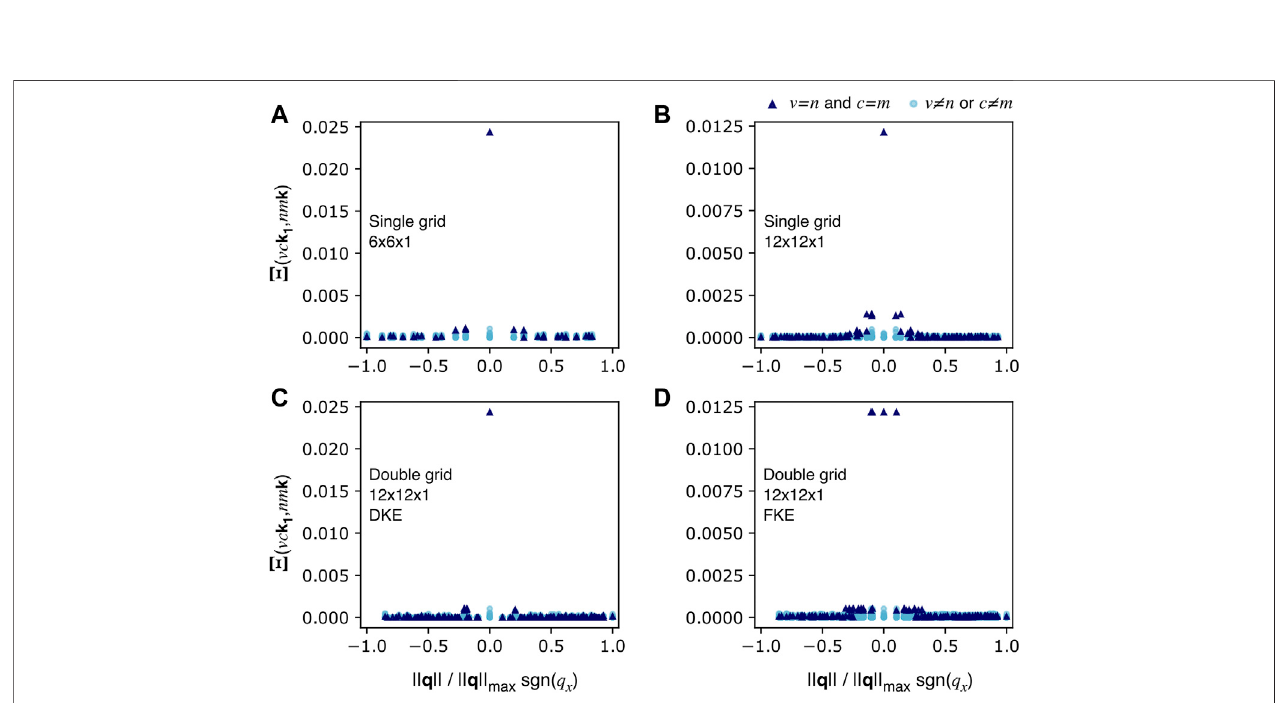
FIGURE 6 | Module of the BSE Kernel matrix element between one transition ( vc k 1 ) and every other transition in the e-h space ( nm k ). The data plotted here corresponds to MoS 2 considering all e-h pairs from the top three valence bands to the fi ve bottom conduction bands. (A) shows the matrix elements considering only a singlegridof6 × 6 × 1 k -points.TheDKEand FKE( (C,D) ,respectively) matrixelementsareobtainedfroma6 × 6 × 1coarse K -gridand a12 × 12 × 1double κ -grid. The fi ne grid data (B) is simply what DKE and FKE try to approximate, i.e., the kernel matrix elements obtained with one single grid of 12 × 12 × 1 k -points.